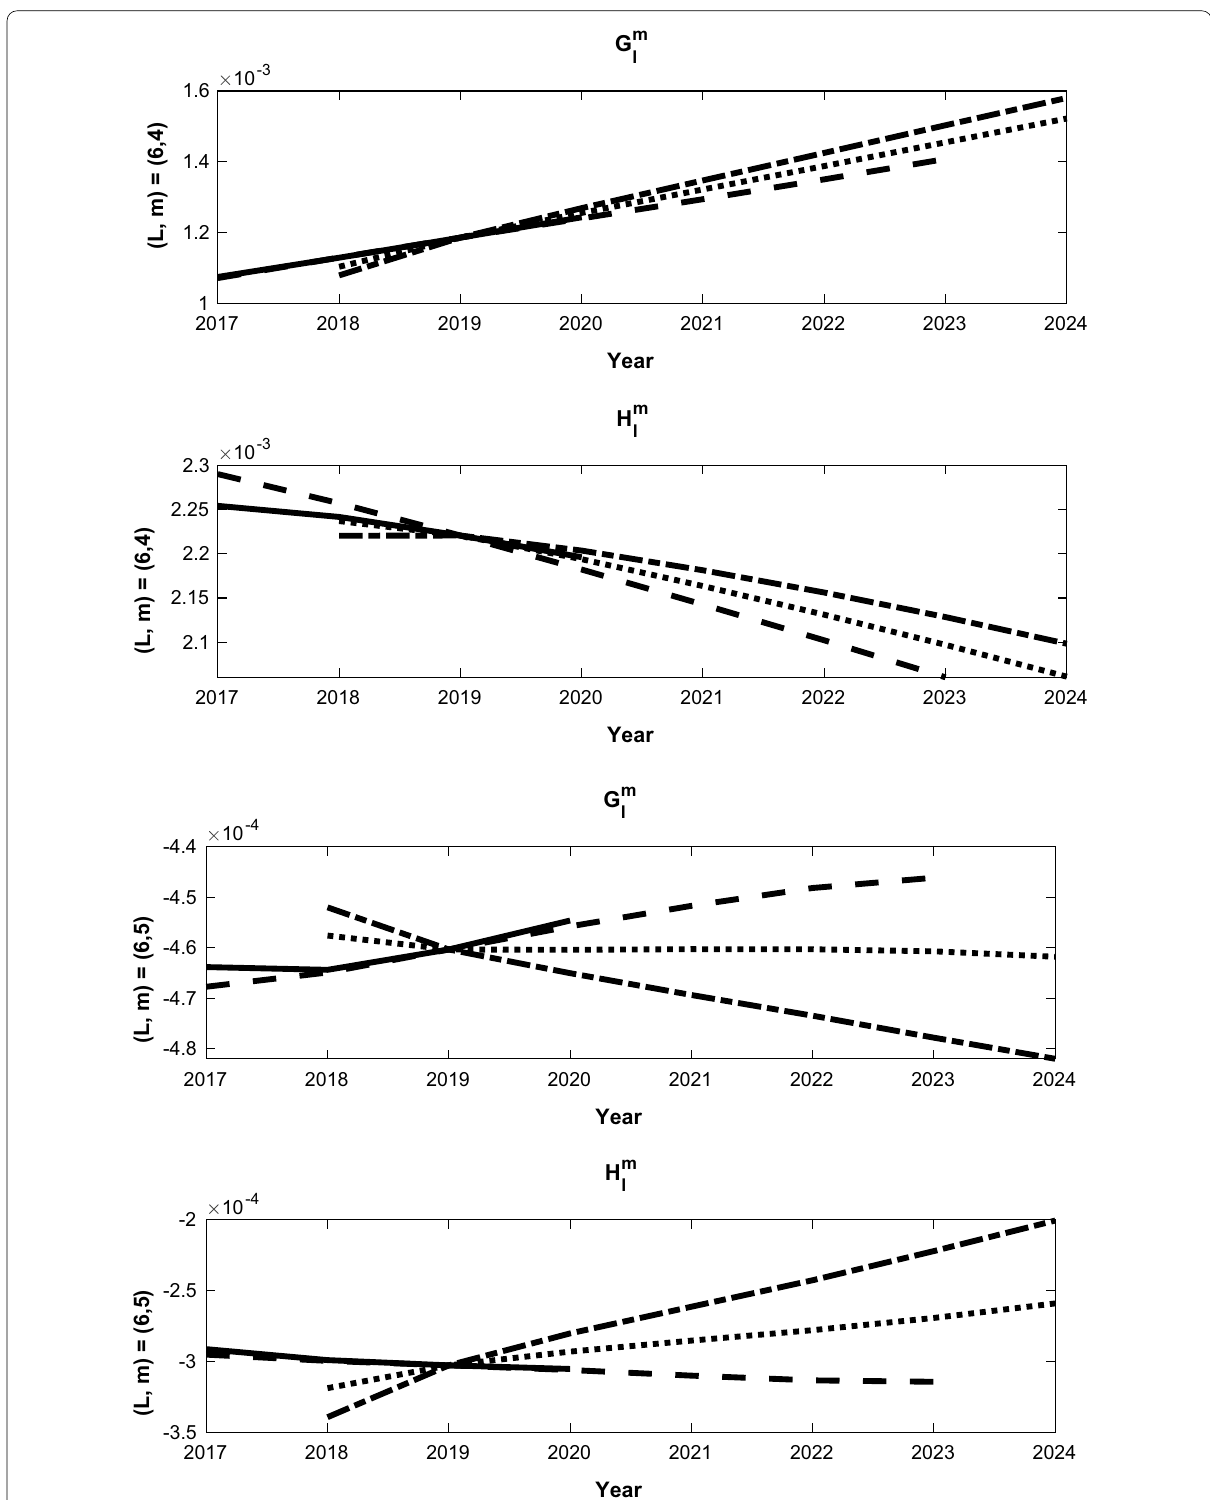
Fig. 6 Same as Fig. 4, except panel ( a ) shows the coefficients for l = 6 and m = 4 , while panel ( b ) shows the coefficients for l = 6 , m =